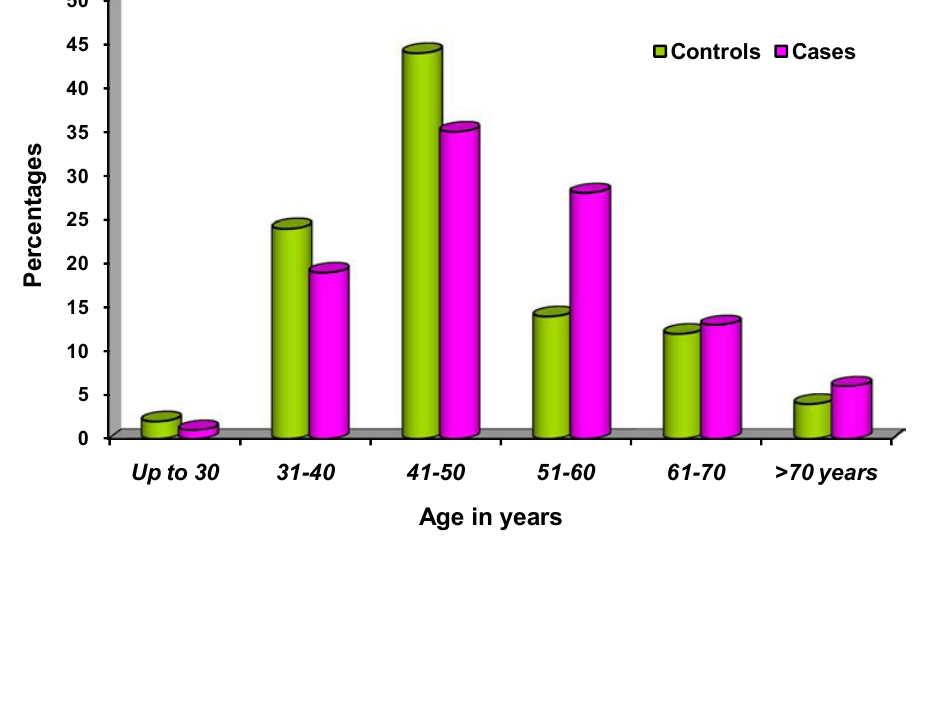
Figure1: Age distribution of subjects